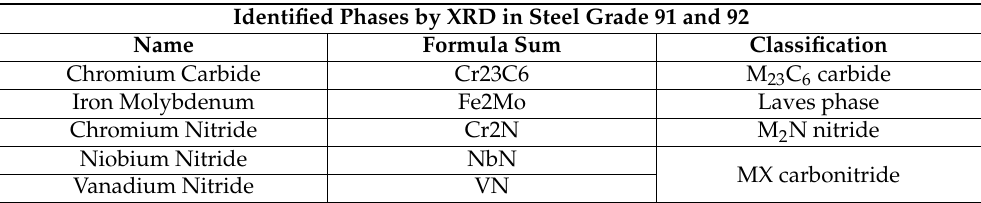
Table 8. Phase identification by automatic